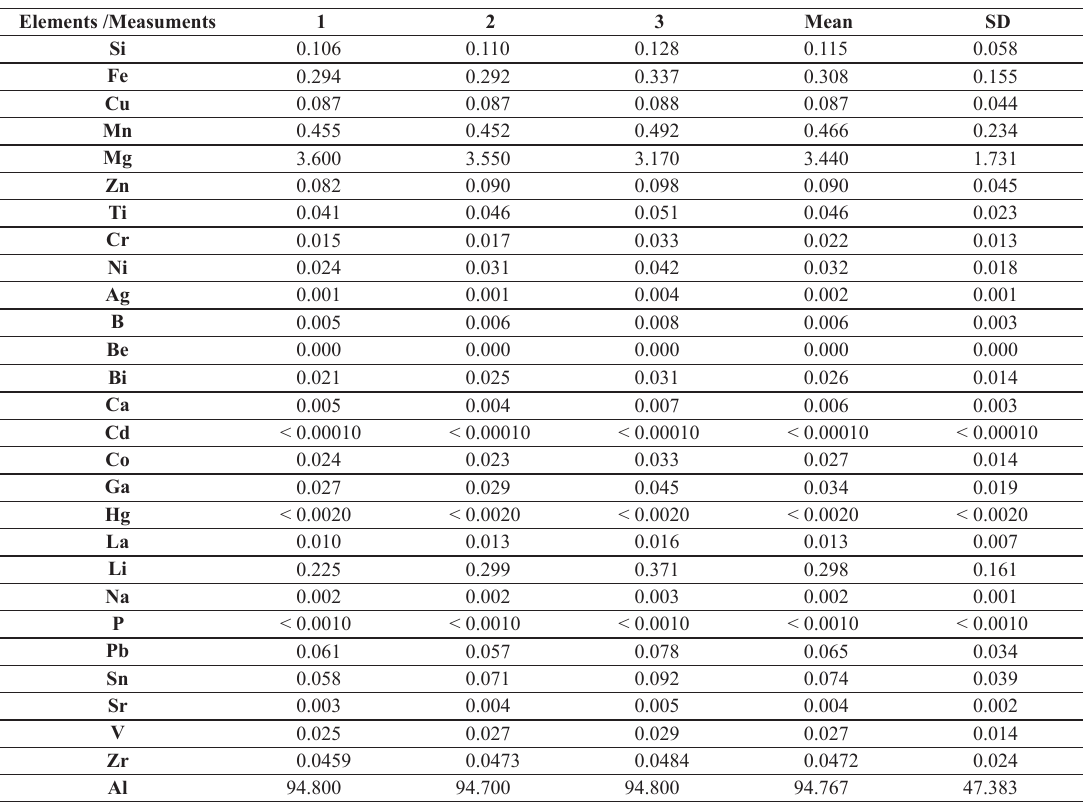
Figure 2. (a) Plates after heat treatments, (b) sheet metal provided for the study, (c) site of chemical composition measurements using optical emission spectroscopy. Table 1. Chemical composition of the aluminum alloy